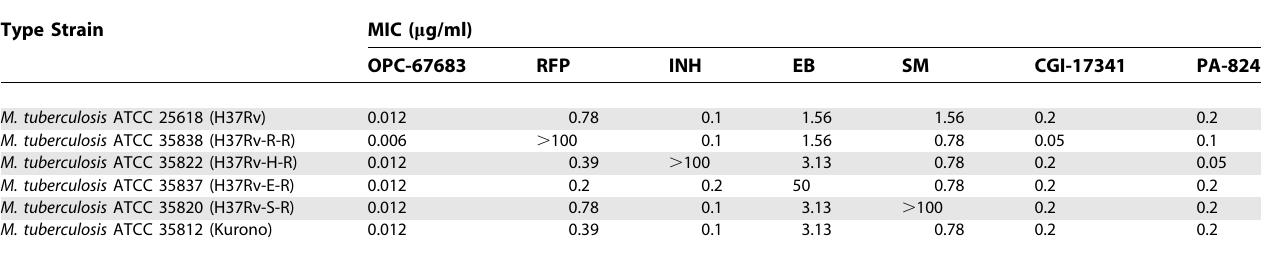
Table 2. In Vitro Anti-Mycobacterial Activity of OPC-67683 Compared with RFP, INH, EB, SM, CGI-17341, and PA-824 Type Strain